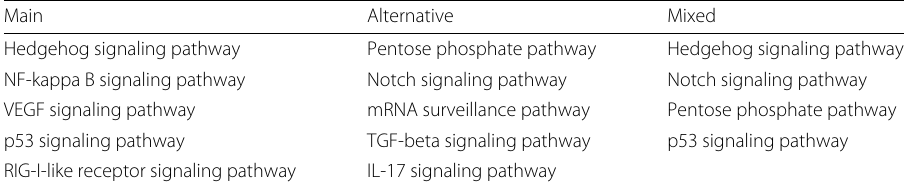
Table 12 Source pathways for the model networks Main